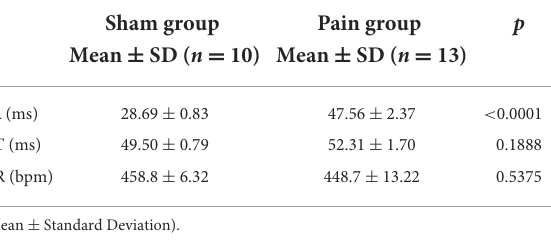
TABLE 1 The measurement of basic electrocardiograms in sham and pain groups. Sham group